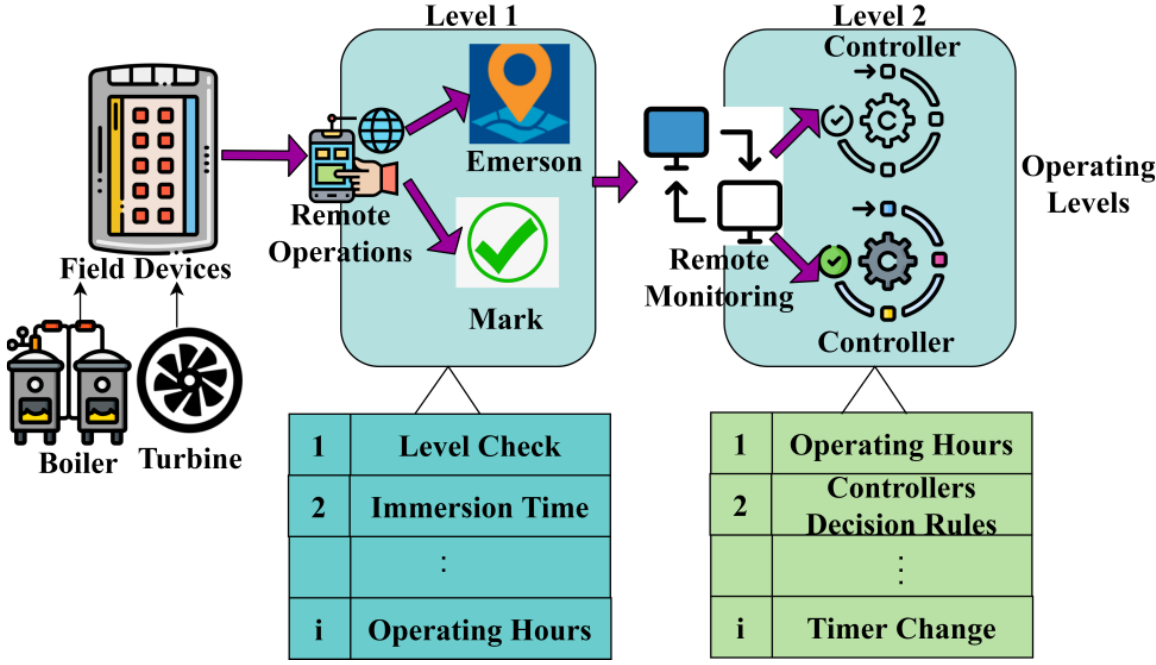
Figure 5. Overview of the Control System Process.